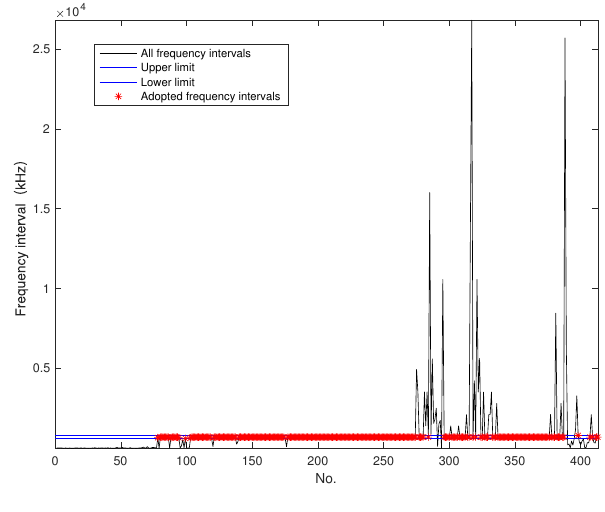
Figure 6. ∆ f i selecting